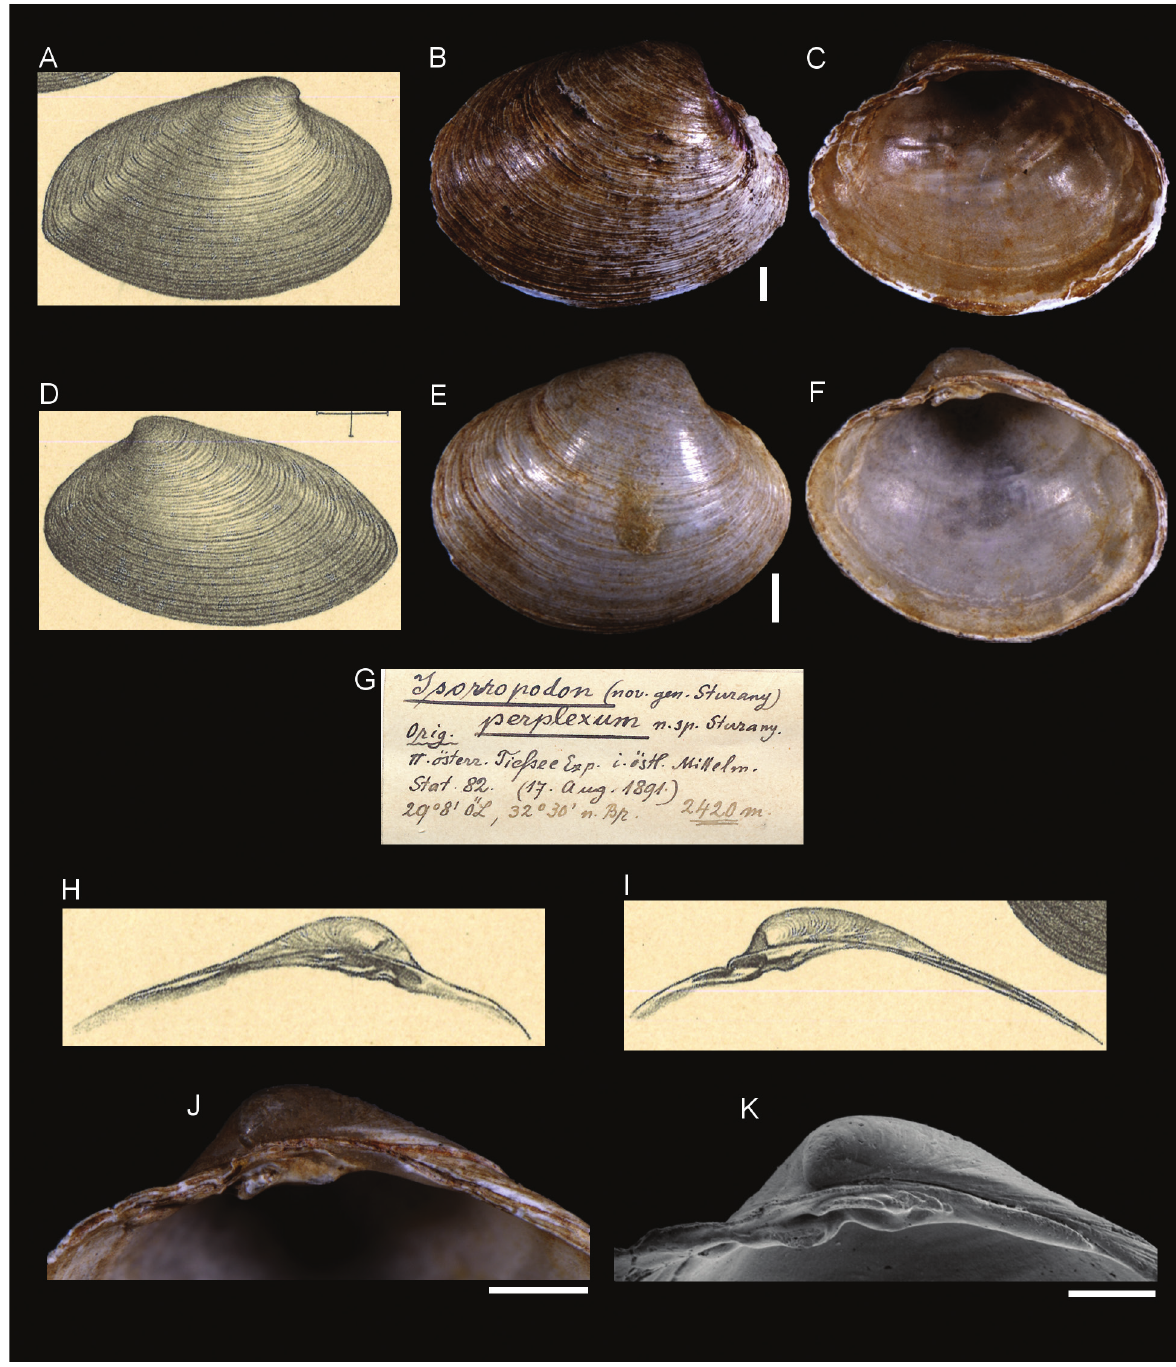
Figure 13. Isorropodon perplexum Sturany, 1896, Station 82, north of Alexandria, Egypt, 2420 m. B–C , K . Syntype NHMW 13010a: outer ( B ) and inner ( C ) views, hinge (K). E – F , J . Syntype NHMW 13010b: outer ( E ) and inner ( F ) views, hinge ( J ). G . Original label. A , D , H–I . Original figures in Sturany, 1896. Scale bar: 1